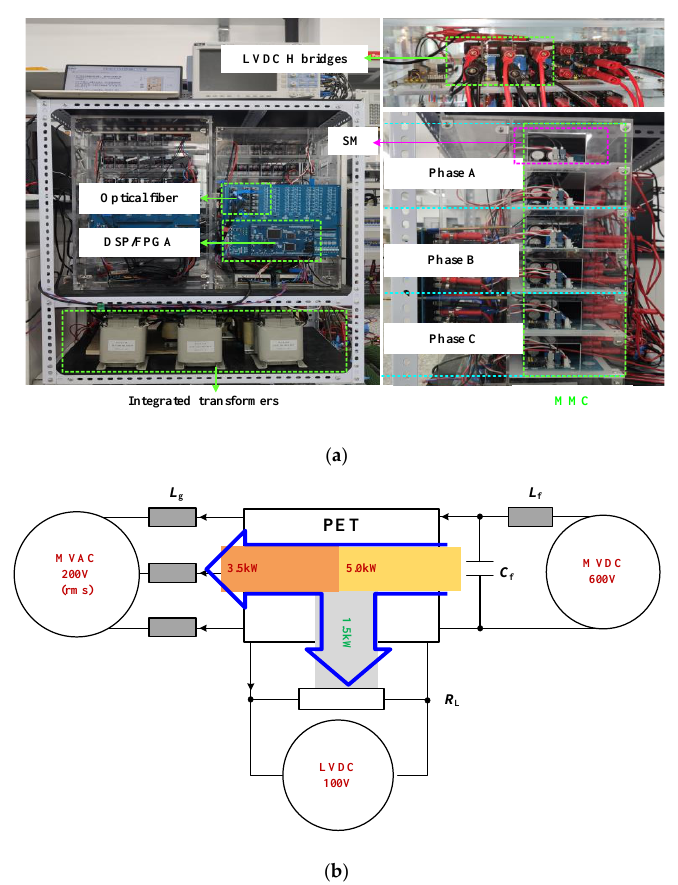
Figure 9. Prototype: ( a ) photograph of the laboratorial three-port PET prototype; ( b ) circuit diagram of the test platform.